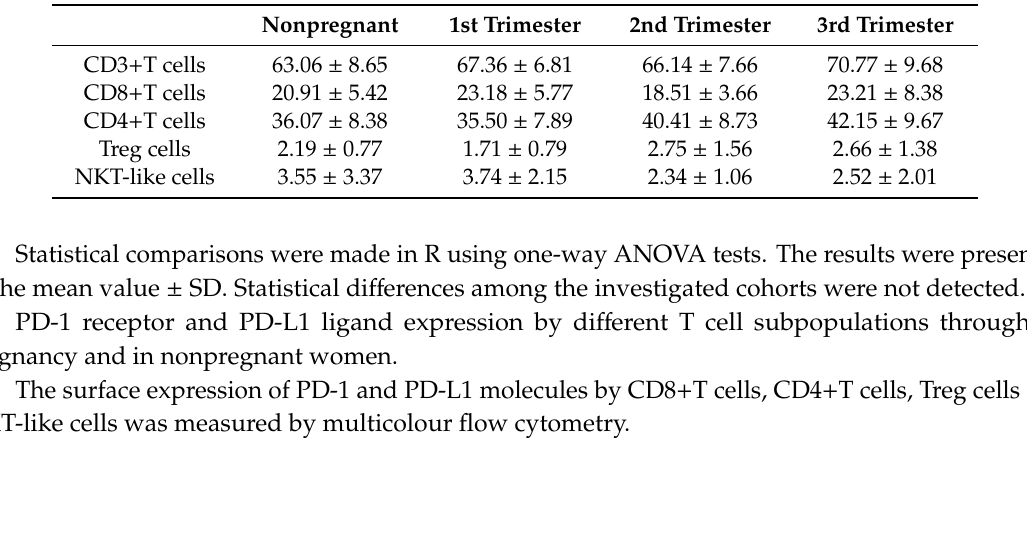
Table 2. Phenotype characteristics of peripheral blood mononuclear cell populations throughout pregnancy and in nonpregnant